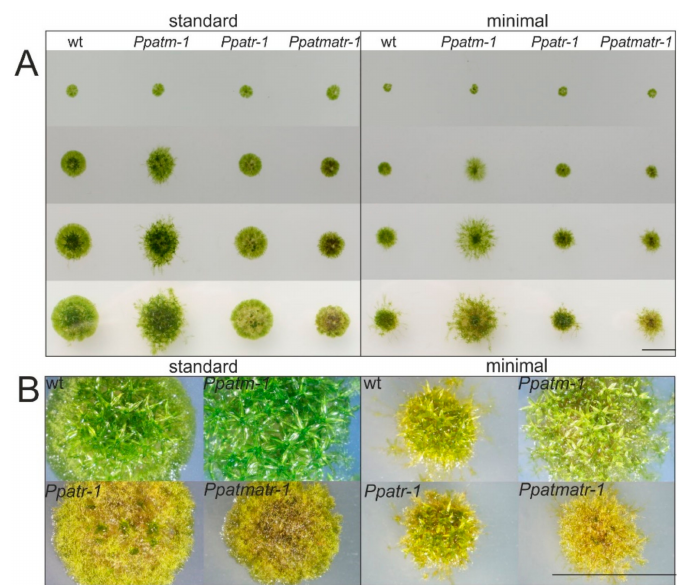
Figure2. Developmentalphenotypesof Ppatm-1 , Ppatr-1 , and Ppatmatr-1 mutantsunderdi ff erentgrowth conditions. ( A ) The pictures show colony growth after transfer of micro-colonies in ordered arrays to standard (left panel) and minimal (right panel) medium under standard conditions. Pictures show colonies after 7 (row 1), 14 (row 2), 21 (row 3), and 28 (row 4) days of growth. ( B ) Magnification of colonies in row 4 showing details in colony morphology and gametophore development. Bars = 1